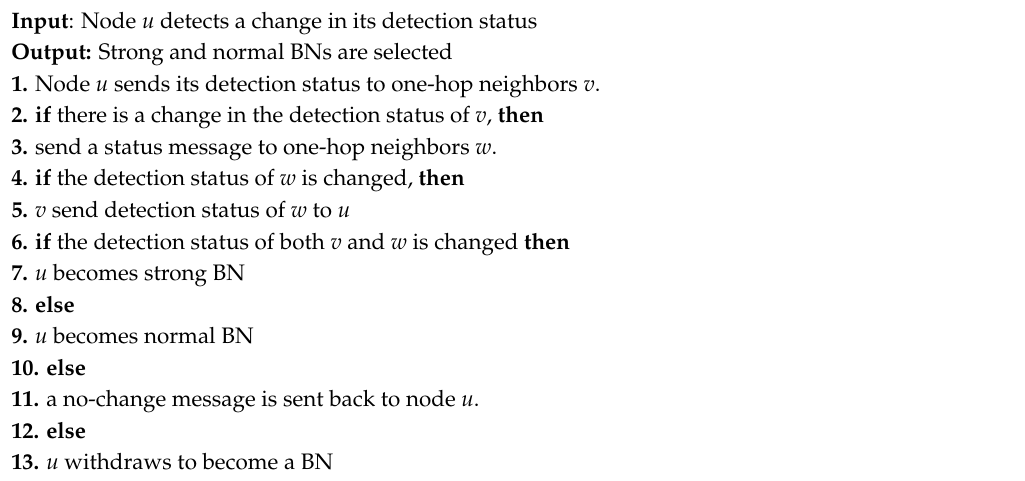
Algorithm 1 Algorithm for Boundary detection and BN selection